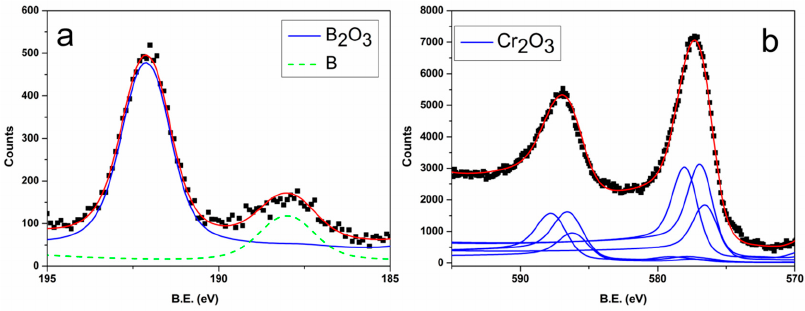
Figure 1. XPS spectra of a film deposited at a substrate temperature of 500 °C from a target with a Cr-B molar ratio of 1:2; ( a ) B 1 s region, and ( b ) the Cr 2 p region. The black points represent the experimental data and the red line represents the data fitting.